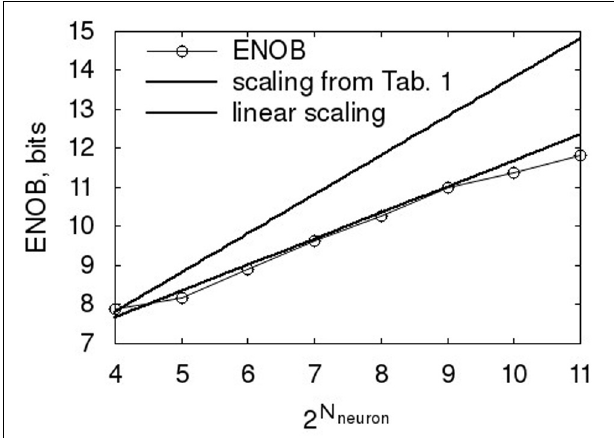
FIGURE 9 | Scaling of ENOB with the number of neurons. Baseline characteristic as in Table 1 .